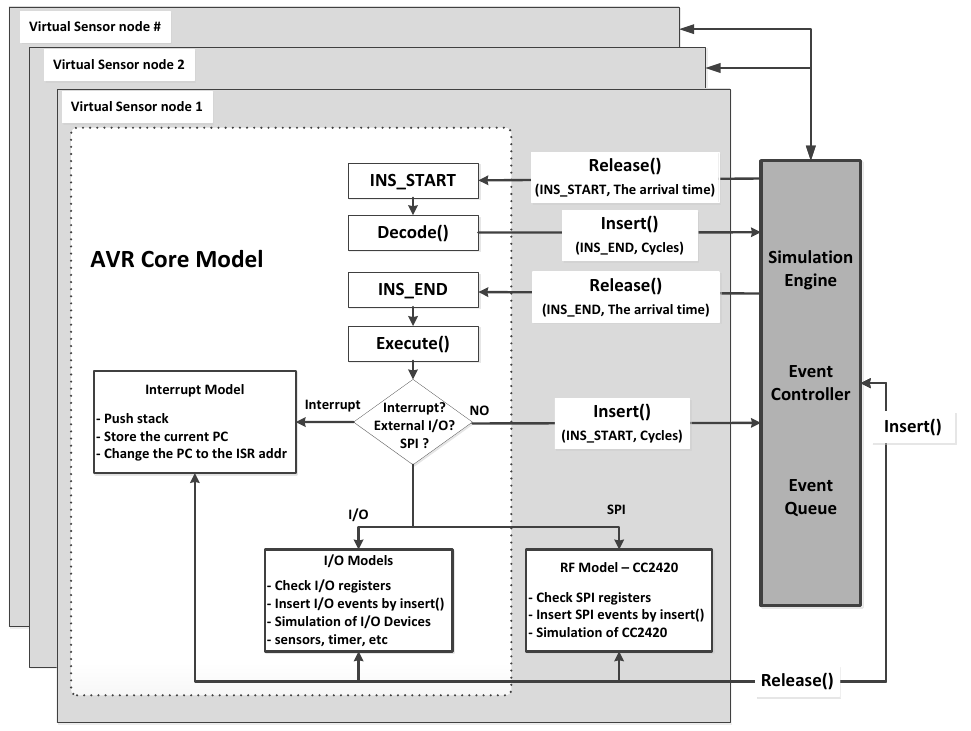
Figure 4. Synchronized simulations using the event queue on the SMPL